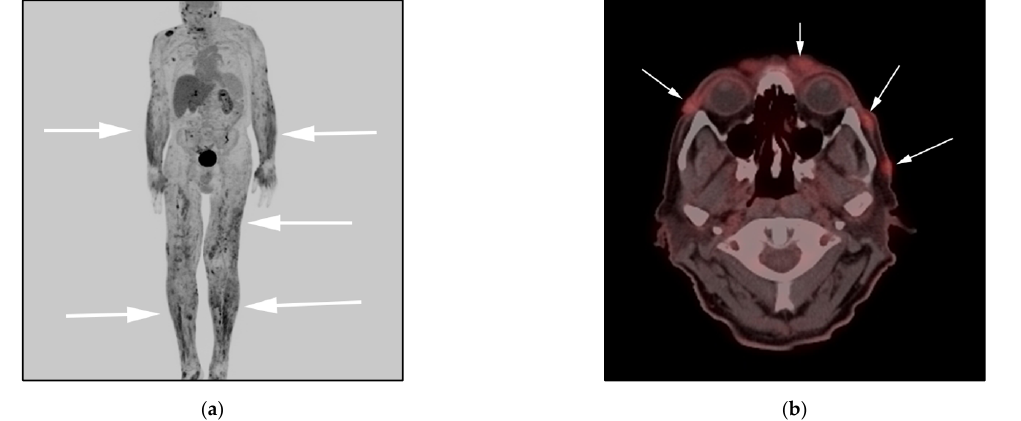
demonstrate peritoneal lymphomatosis, and/or omental and mesenteric masses, resem- bling disseminated DLBCL [19]. Imaging may be requested to differentiate between cutaneous and systemic ALCL AKL variants. FDG PET/CT has a particularly important role in differentiating between the systemic ALCL AKL-positive variant that demonstrates higher uptake compared with ALK-negative ALCL cases [19]. Differentiation is important as it has consequential prog- nosis and treatment implications [22] (Figure 3).